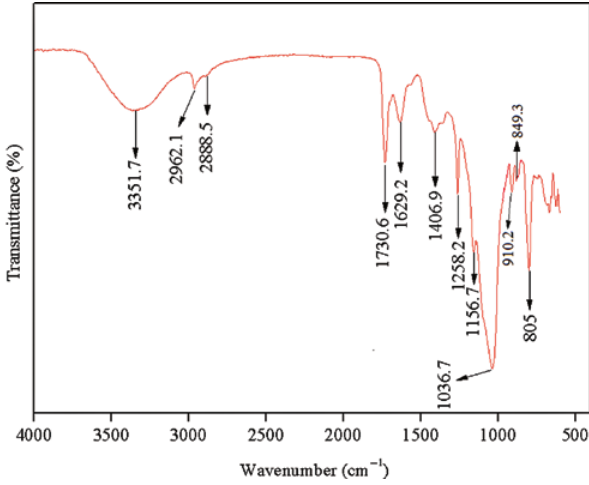
Figure 1: ATR-IR spectrum of